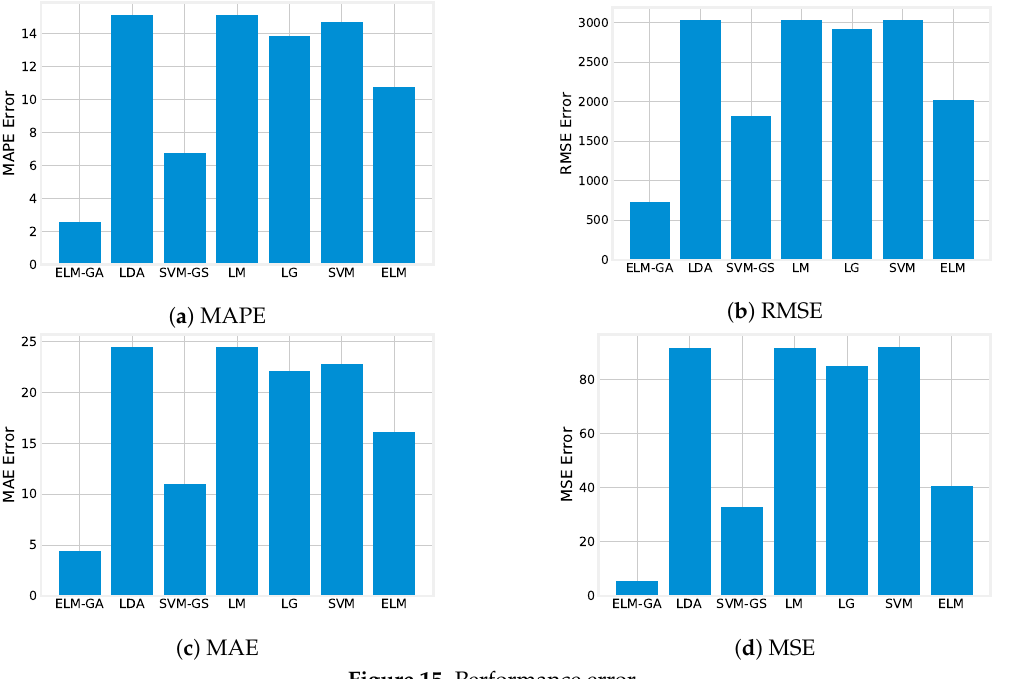
Figure 15. Performance